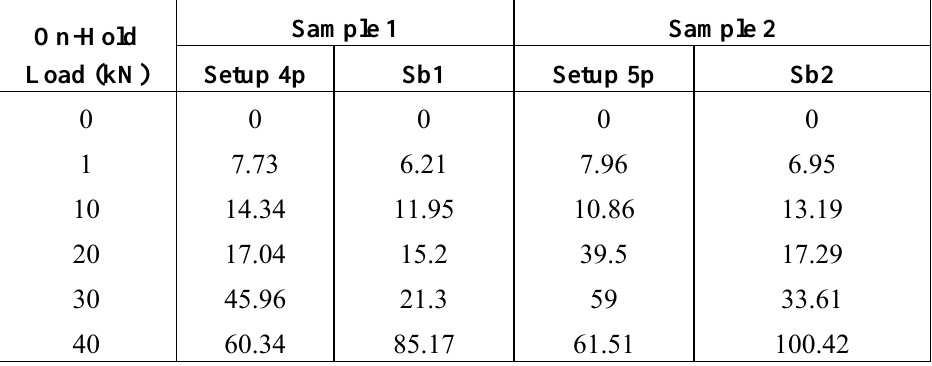
Table 4. RMSD values for reusable PZT setups and surface bonded